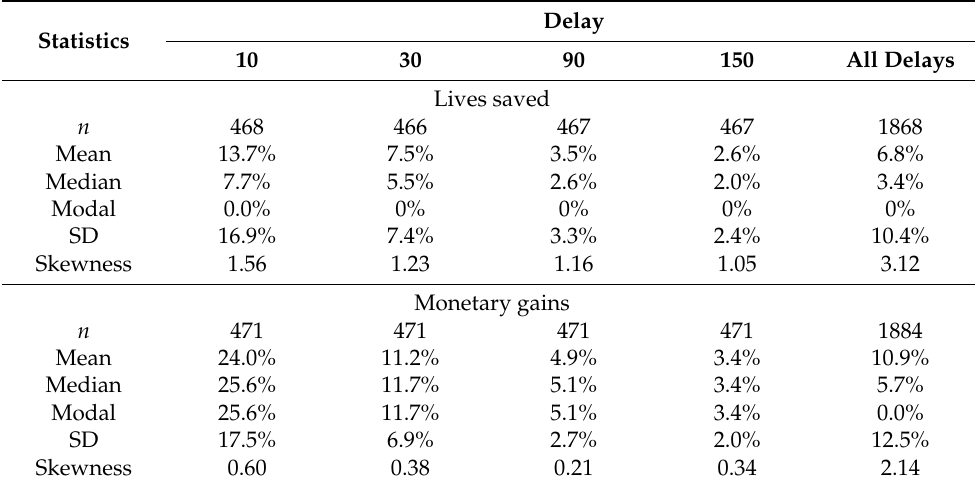
Table 1. Descriptive statistics for lifesaving program and monetary gains.